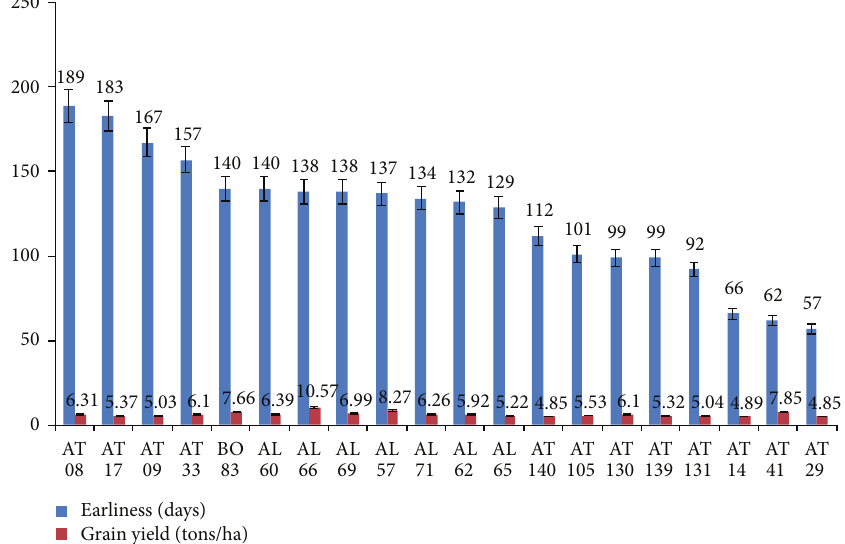
Figure 4: Twenty sorghum elite genotypes identified based on grain yield and days to 50%